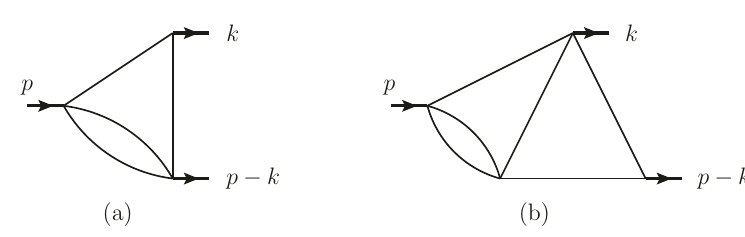
Figure 4 . Three-mass triangle integrals with massless propagators, which appear in the calculation of the wavefunction at two and three loops. These integrals contribute to the amplitude only starting respectively at four and (cid:12)ve loops, due to symmetry constraints, as discussed in the main text. The bubble integral on one of the edges of the triangle clari(cid:12)es the origin of the propagator which is raised to power (cid:15) in eq.